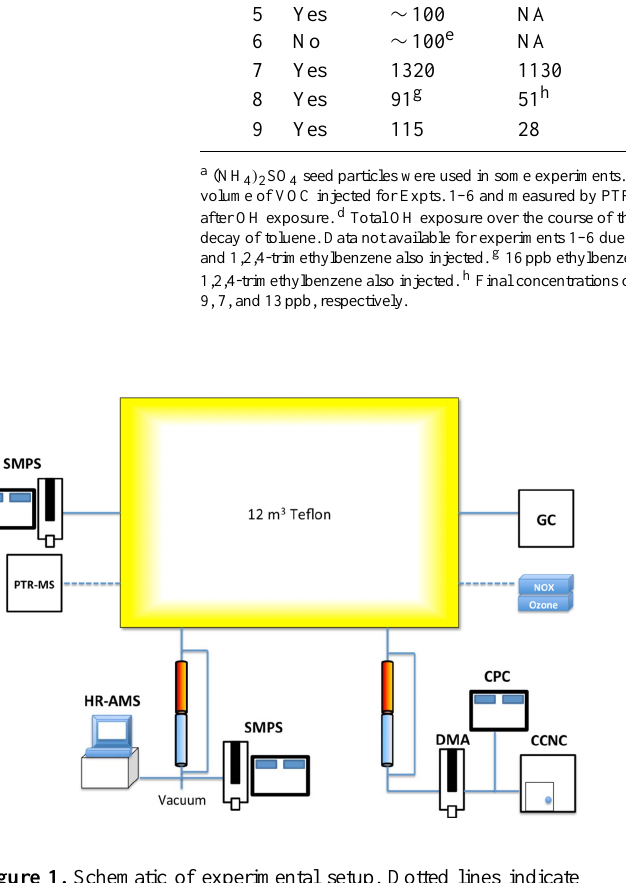
Figure 1. Schematic of experimental setup. Dotted lines indicate that the equipment was used in selected